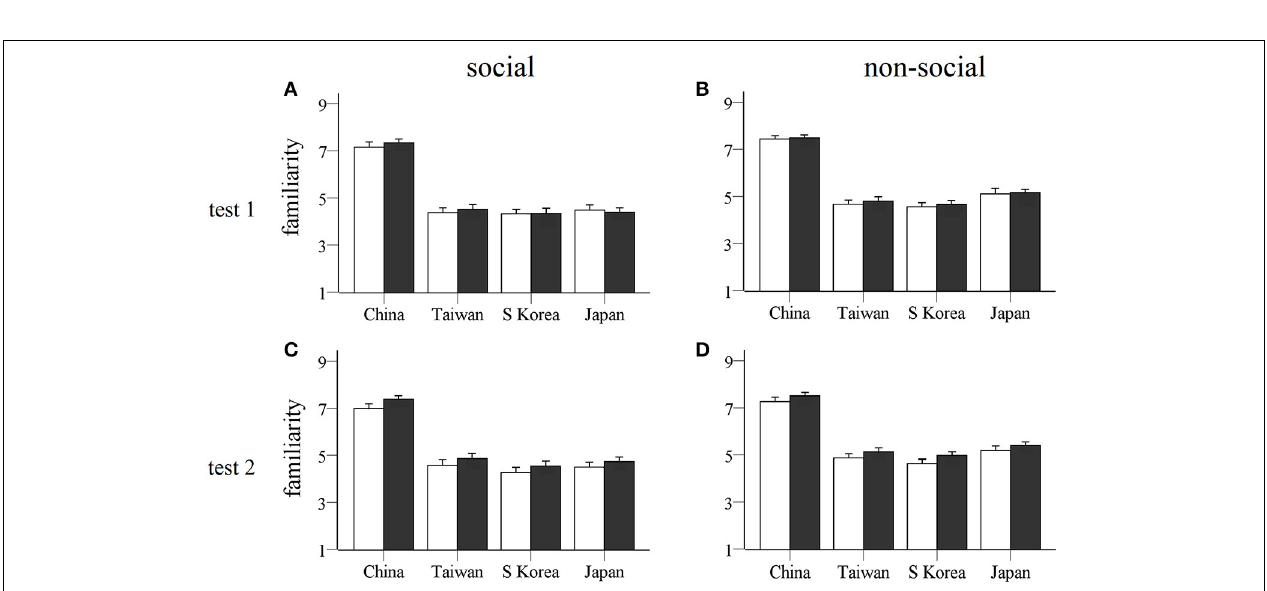
(filled bars) and PLC (unfilled bars) treated subjects in the two tests ( A,B : test 1, 45min after OXT/PLC treatment; C,D : test 2, 7 days after treatment). No significant treatment effects were found.